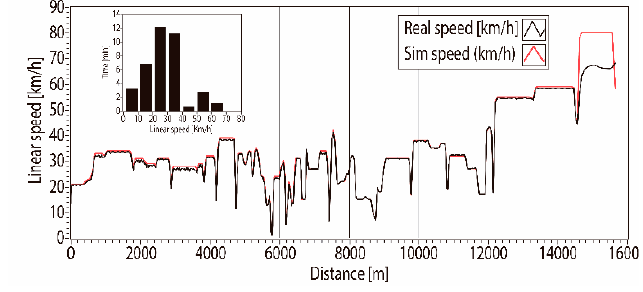
Figure 21. Lineal vehicle speed.